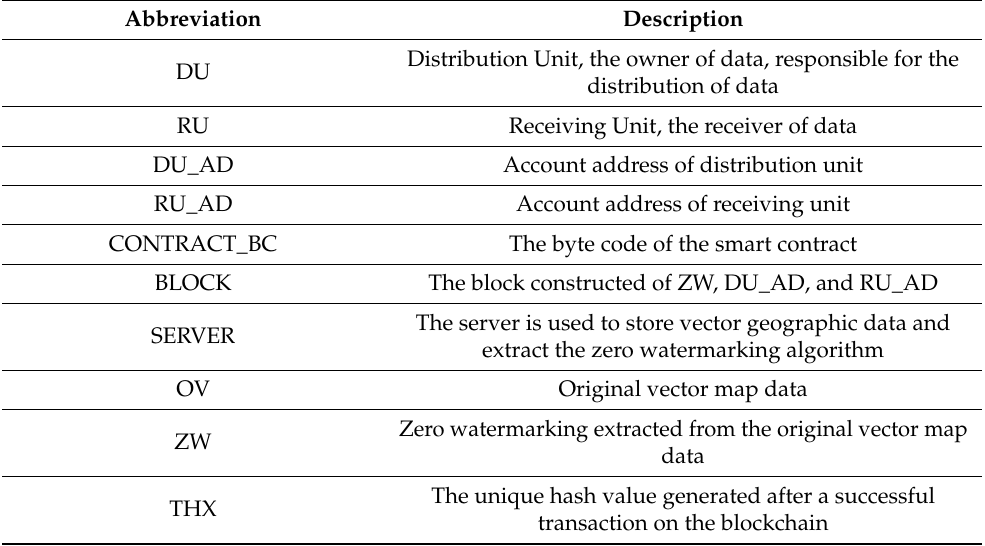
Table 1. The abbreviations in smart contract